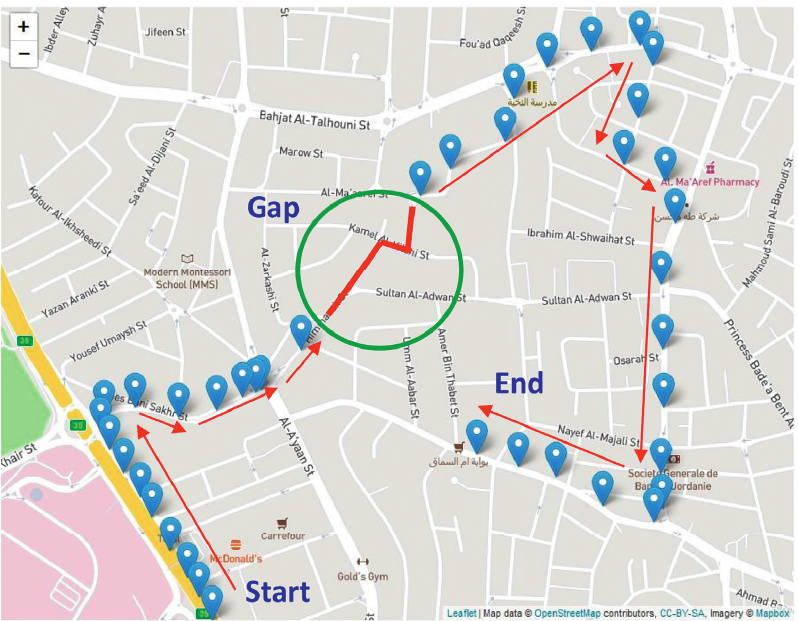
Figure 21: A trip path in which there is a short